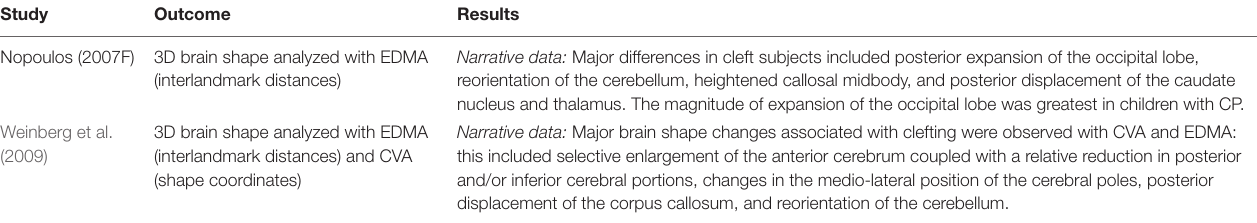
TABLE 4 | 3D morphometric analysis of brain shape. Study Outcome Results